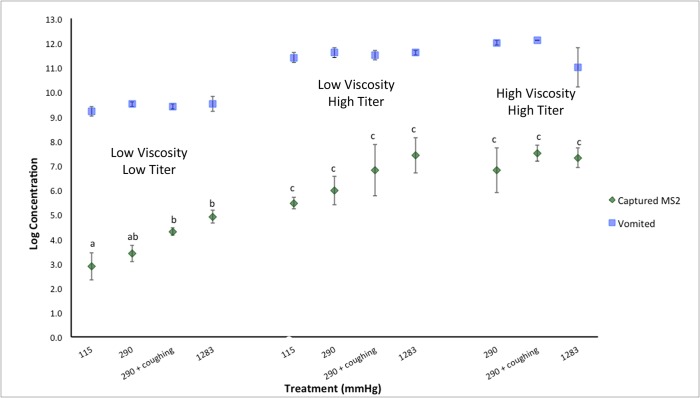
Aerosolization Experiments using bacteriophage MS2.Virus concentration “vomited” is designated by blue squares. Green diamonds show the amount of captured MS2 at designated pressures for simulated vomitus having low and high MS2 titer and of low and high viscosity. Error bars denote one standard deviation above the mean. Shared letters and symbols indicate treatments that were not statistically significantly different within each group.